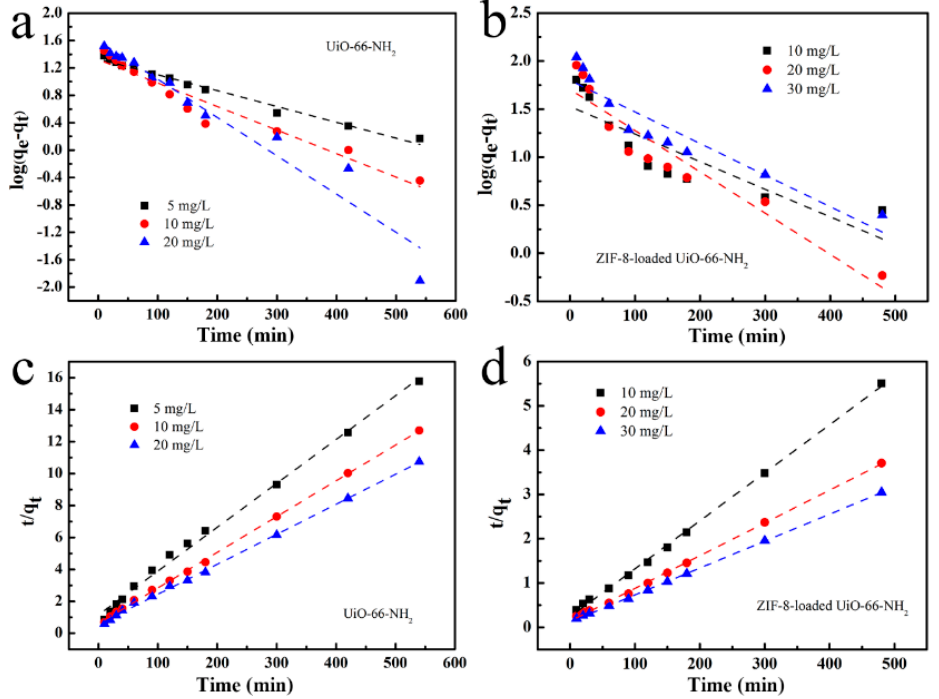
Figure 7. Pseudo-first-order and pseudo-second-order kinetics model for adsorption of methylene blue (MB) onto UiO-66-NH 2 ( a , c ) and zeolitic imidazolate framework-8 (ZIF-8)-loaded UiO-66-NH 2 ( b , d ). Table 4. Values of the kinetic parameters for 1-zeolitic imidazolate framework-8 (ZIF-8)@UiO-66-NH 2 and UiO-66-NH 2 . Pseudo-first-order kinetic Adsorbent q e